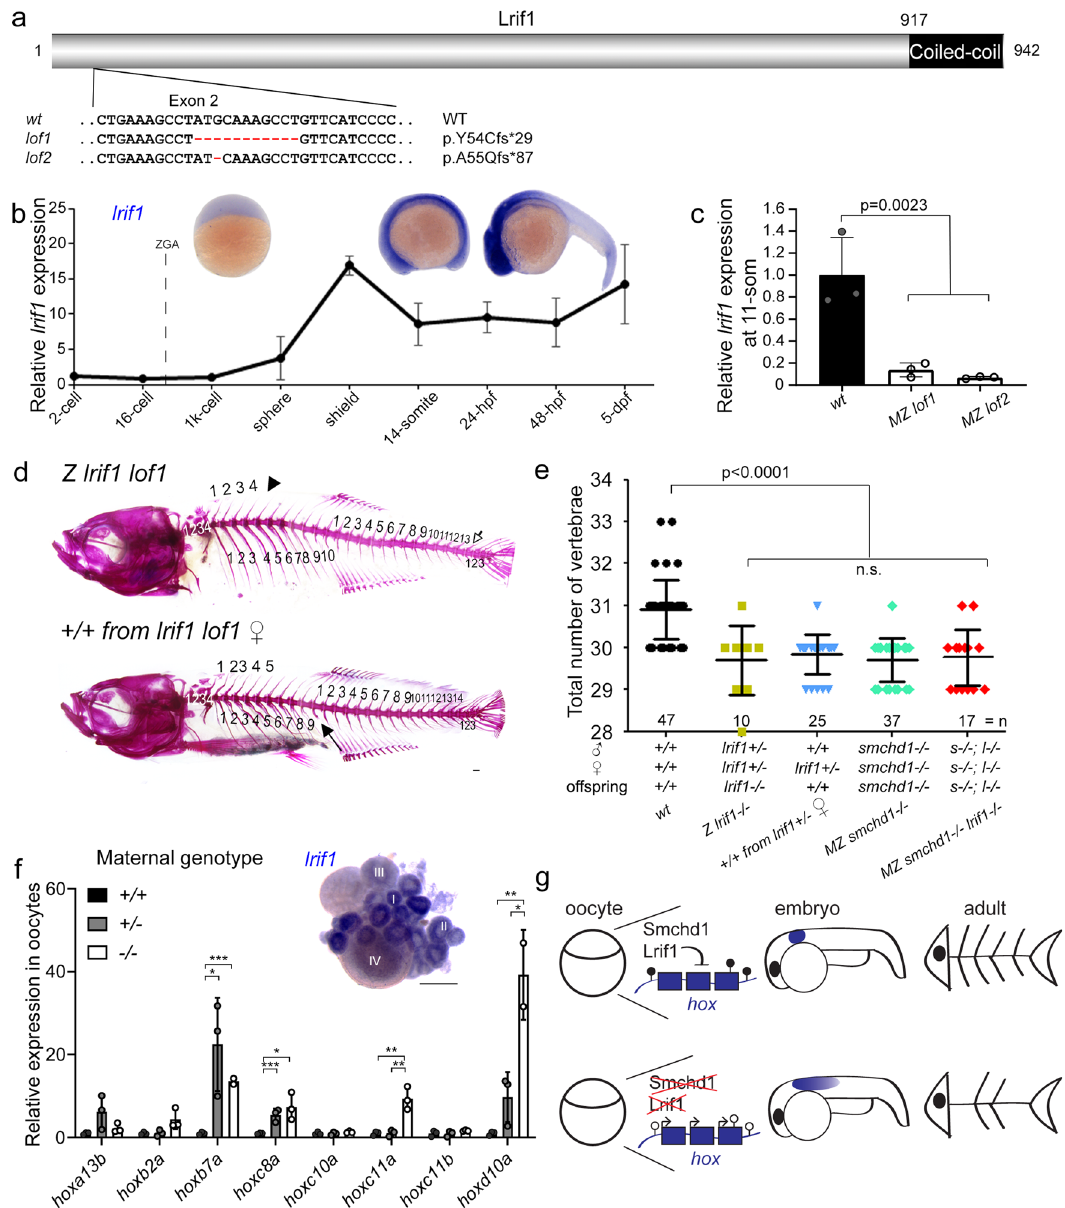
Fig. 5 Knockout of lrif1 phenocopies, and does not aggravate, that of smchd1 . a Two loss of function alleles of lrif1 were generated in zebra fi sh by CRISPR/ Cas9 injections. b Endogenous spatial-temporal expression pattern of lrif1 in zebra fi sh embryos as determined by qPCR and WISH. n = 3 biological samples (qPCR), 3 independent experiments with at least 20 embryos each (WISH). c Maternal zygotic (MZ) lrif1 lof embryos lack lrif1 mRNA suggestive of total nonsense-mediated decay. n = 3 biological samples. P values were calculated by 2-tailed unpaired Student ’ s t test. d , e Axial skeletal patterning defects in adult fi sh. Phenotypes include loss of a rib ( fi lled arrow), loss of a supraneural vertebra (arrowhead) and loss of a caudal vertebra (open arrow). P values were calculated by the Kruskal-Wallis test followed by Dunn ’ s Multiple Comparison Test. f qPCR shows that hox derepression is detected in unfertilized oocytes from both + / − and − / − females. P values were calculated by 2-tailed unpaired Student ’ s t test. Inset shows expression of lrif1 in Stage I and II oocytes. Scale bars = 200 µ m. n = 3 biological samples (qPCR), 5 ovaries of adult fi sh (WISH). g Model of Smchd1/Lrif1-driven transgenerational inheritance for skeletal patterning. Smchd1/ Lrif1 sets up an epigenetic state during oogenesis to ensure correct expression of hox genes during embryogenesis which in turn patterns the vertebrae. * p < 0.05, ** p < 0.01, *** p < 0.001. All data are presented as mean values ±